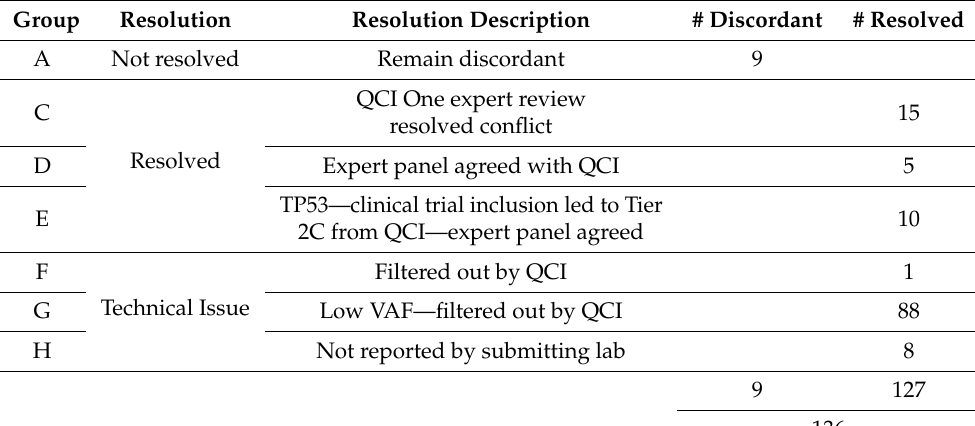
Table 4. Classification discrepancies in solid